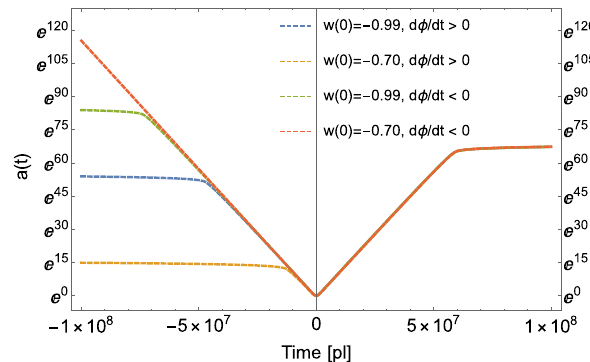
Fig. 1 Evolution of the scale factor a ( t ) before, during and after the bounce, for different initial